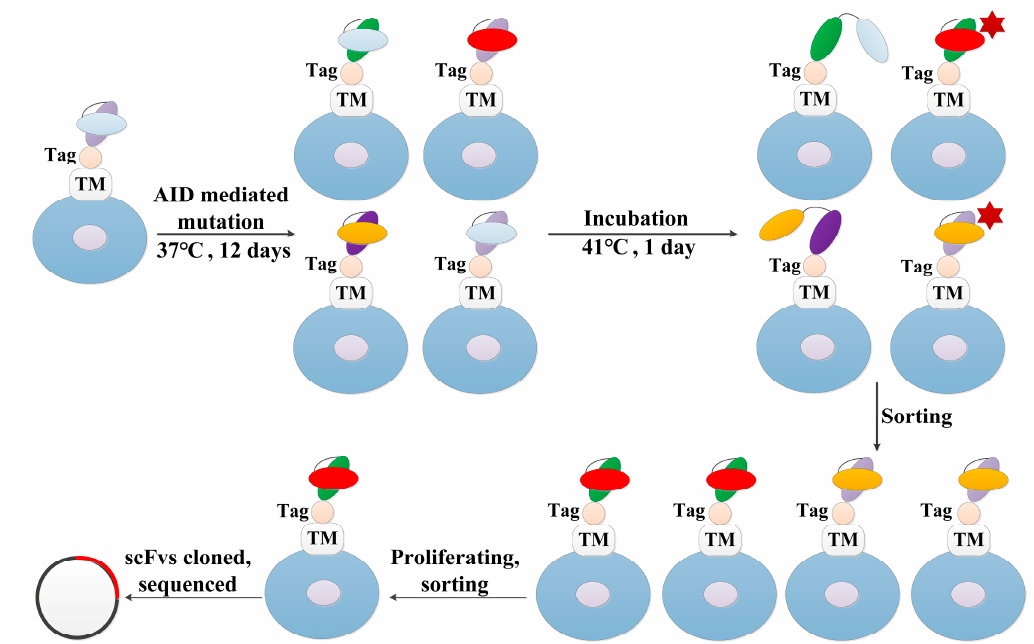
Figure 2. Procedure selecting more stable antibody variants. The TR cells bearing anti-TNF α scFv gene were transfected with AID gene for antibody mutagenesis. After culturing for 12 days at 37 °C to generate mutant scFvs (two linked-ovals), the cells were cultured at 41 °C for 24 h before being labeled with GFP-TNF α star symbol and anti-HA antibody at 42 °C, and flow cytometric sorting for the cells highly displaying the antibodies with the highest antigen-binding abilities. Then, the collected cells were proliferated, and the next round of sorting was performed. Tag: Human influenza hemagglutinin for monitoring antibody display level. TM: transmembrane peptide for anchoring scFv to the surface of the cell.